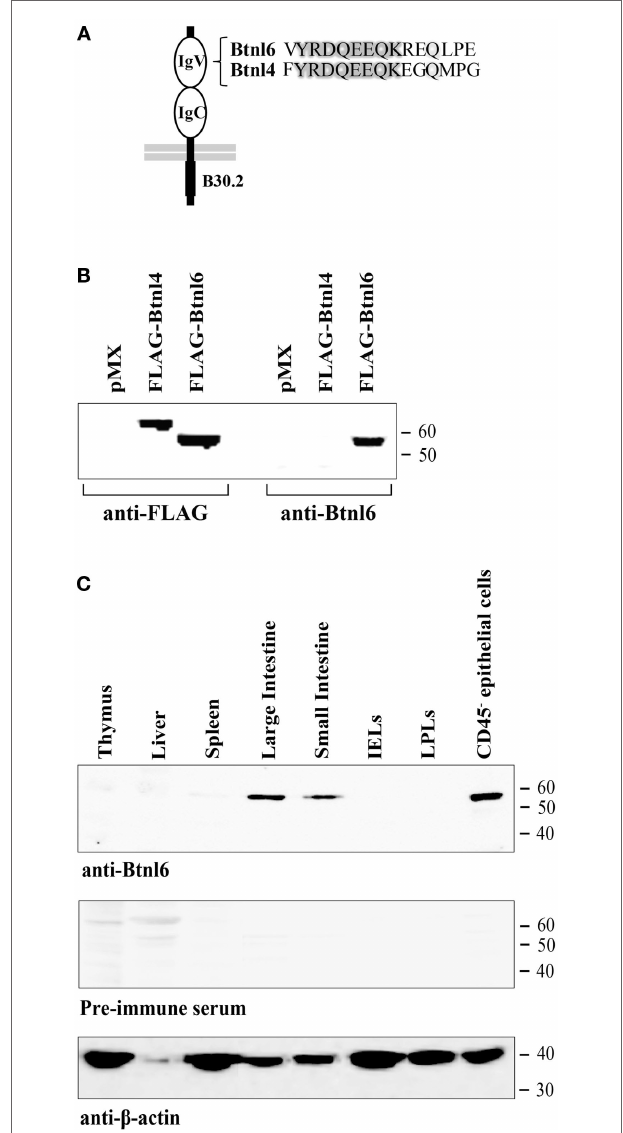
FigUre 1 | Validation of the Btnl6 antibody and Btnl6 protein expression in tissue. (a) A rabbit anti-mouse Btnl6-reactive antibody was developed against a synthetic peptide (residues 79–93). Peptide alignment across Btnl4 and 6 is shown. (B) Lysates from HEK 293 cells transfected with FLAG-tagged Btnl4 cDNA pMX-IRES-GFP, FLAG-tagged Btnl6 cDNA pMX-IRES-GFP, or empty vector (pMX-IRES-GFP) were divided and immnoblotted either using anti-FLAG- or anti-Btnl6 antibody. A single band consistent with the theoretical molecular weight of ~64 kDa for FLAG-tagged Btnl4 and ~59 kDa for FLAG-tagged Btnl6 was detected under reducing conditions when immunoblotted with anti-FLAG. Anti-Btnl6 antibody detected Btnl6 transfectants, but not Btnl4 transfectants or HEK 293 cells transfected with empty vector. (c) Tissues from C57BL/6 mice were analyzed for Btnl6 protein expression using a Btnl6-specific polyclonal antibody. A single band consistent with the theoretical molecular weight of ~58 kDa for Btnl6 was detected in large and small intestine, and in small intestinal epithelial cells under reducing conditions. No bands were detected on gels immunoblotted with preimmune serum. The β -actin immunoblot acts as a loading control. IELs, intraepithelial lymphocytes; LPLs, lamina propria lymphocytes. Data are representative of two